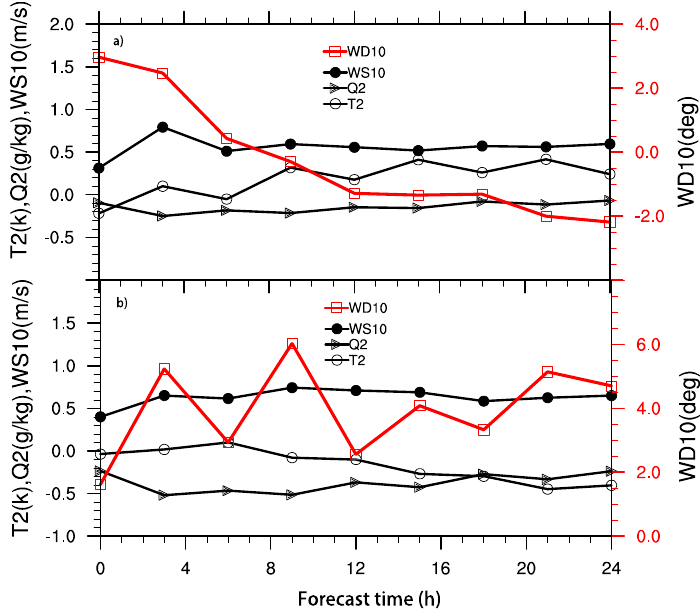
Figure 13. Bias in T2 (black circles), Q2 (black triangle), WS10 (black dot) and WD10 (red square) as a function of forecast lead time (h) from control forecasts in ( a ) January and ( b ) July.